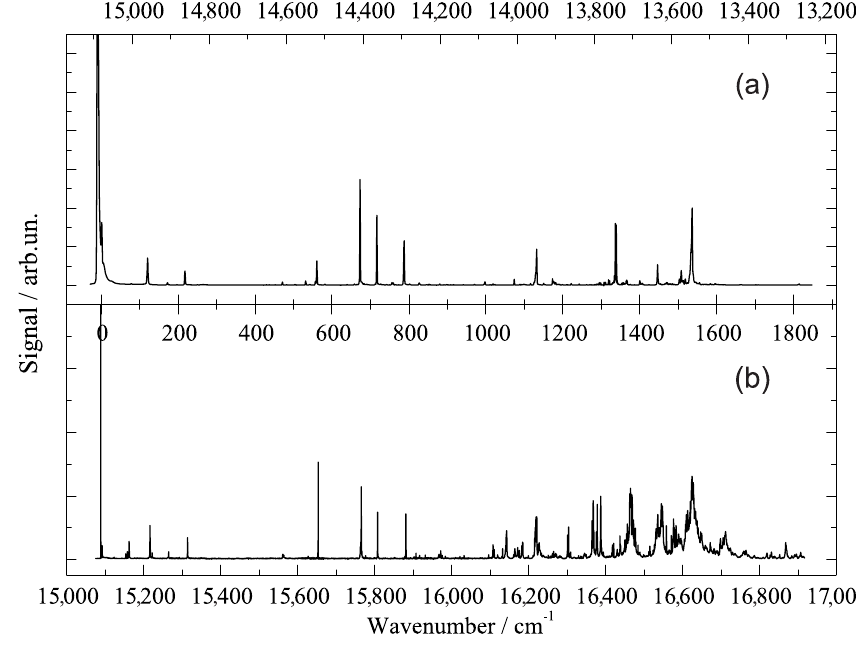
Figure 1. Electronic spectra of phthalocyanine in superfluid helium droplets at an average size of 20,000 atoms. ( a ) Dispersed emission spectrum recorded upon excitation at the electronic origin; ( b ) fluorescence excitation spectrum starting at the electronic origin of the S 1 –S 0 transition. Top and bottom abscissa show the corresponding absolute wavenumber scale while the center abscissa is adjusted to the common origin of both